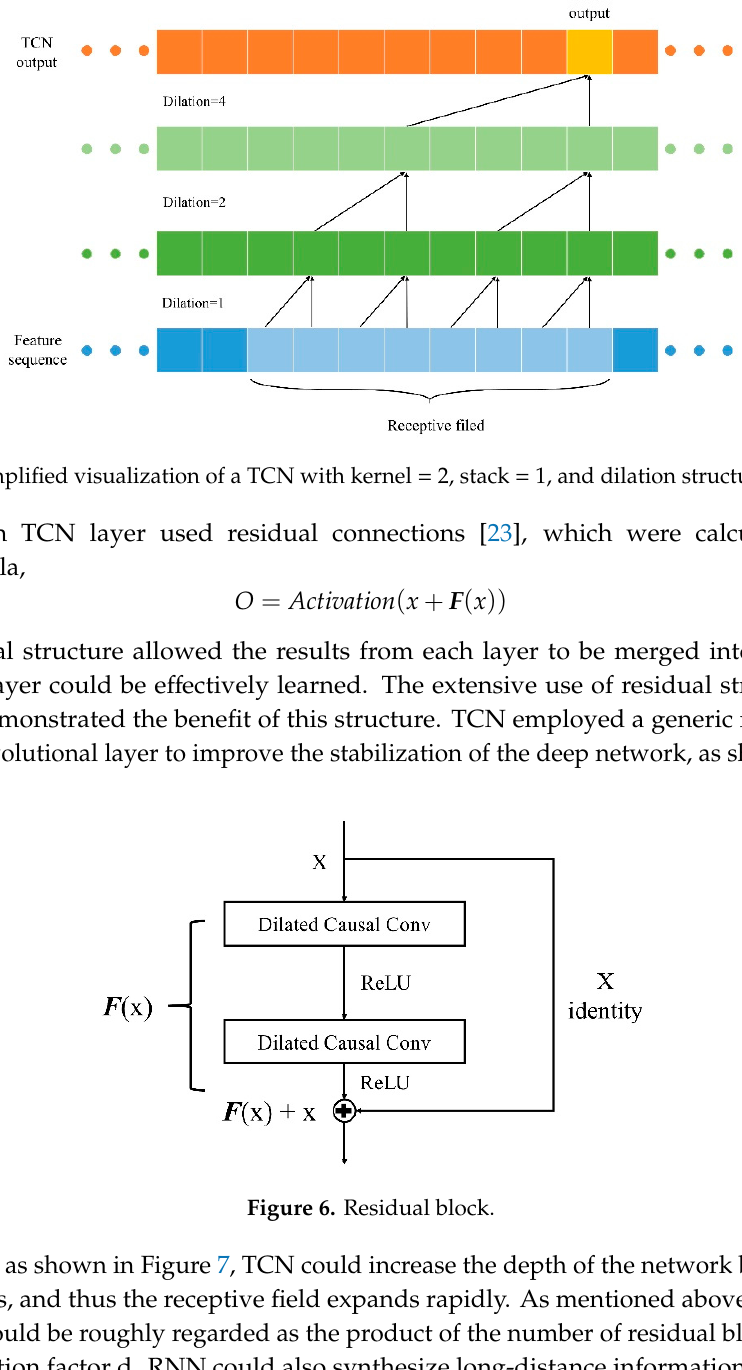
Figure 4. Simplified visualization of causal convolution and conventional convolution.